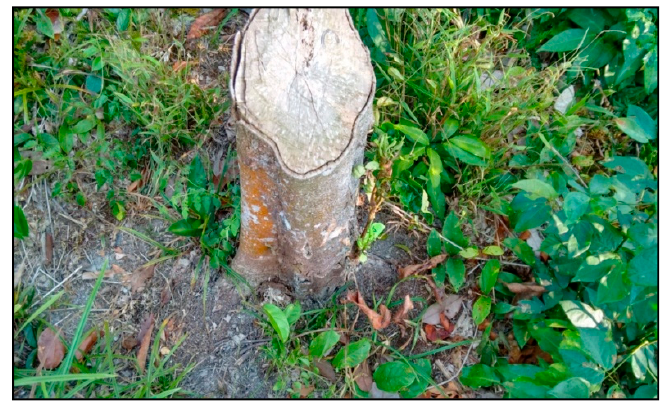
Figure A3. Image of tree cut at 50 cm from the ground as required by law. Forests 2017 , 8 , 327